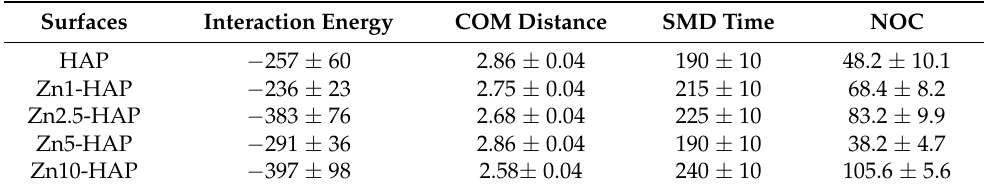
Table 1. Interaction energy (kJ/mol), center of mass (COM) distance (nm), SMD time (ps), and number of contacts (NOC, <0.3 nm, count by residues) of BMP-2 upon HAP and Zn-HAPs at the binding